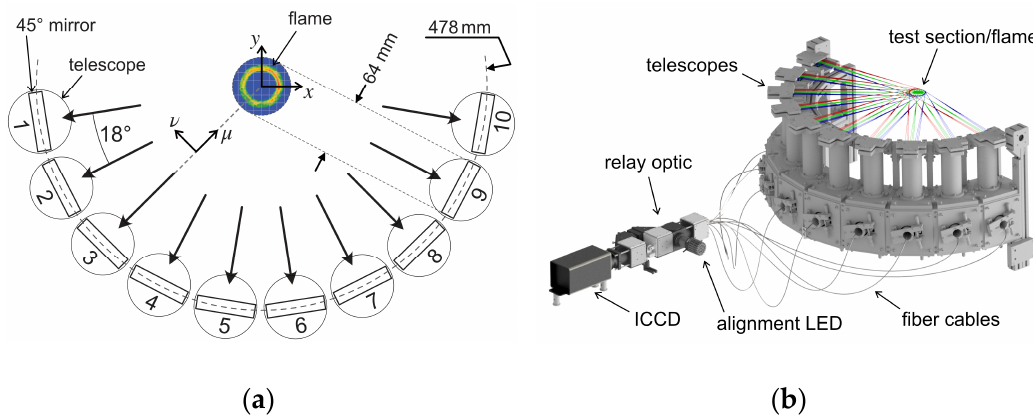
Figure 2. ( a ) Schematic illustration of the tomographic setup (POET λ ). The emission of the flame was imaged by ten 45° deflection mirrors and suitable telescopes onto individual rows of optical fibers. ( b ) 3D illustration of telescopes, optical fiber cables, relay optic and camera.